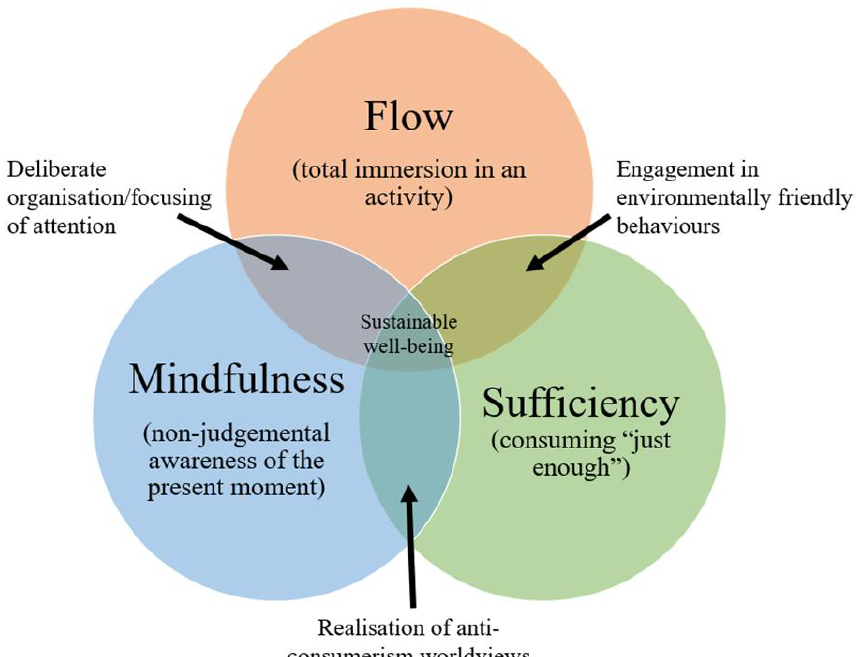
Figure 1. Different individual routes to sustainable well-being and their common features.